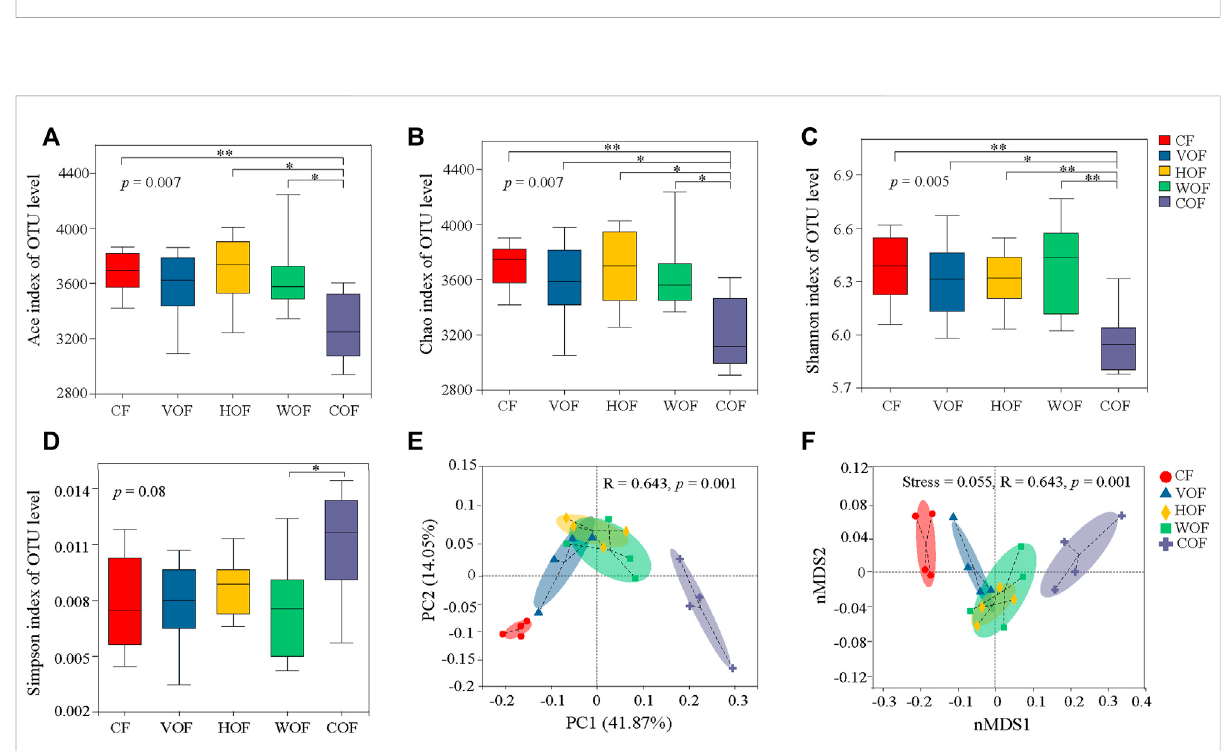
FIGURE 4 Hierarchical clustering tree of samples in bacterial community at the phylum (A) and genus (B) level in the rhizosphere soil. The horizontal histogram shows the species composition in top nine phylum (A) and top 16 genus (B) in different treatments. CF, VOF, HOF, WOF, and COF represent the treatments of tobacco-special chemical fertilizer, vermicompost-based, humic acid-based, wood biochar-based, and compound functional organic fertilizers, respectively.